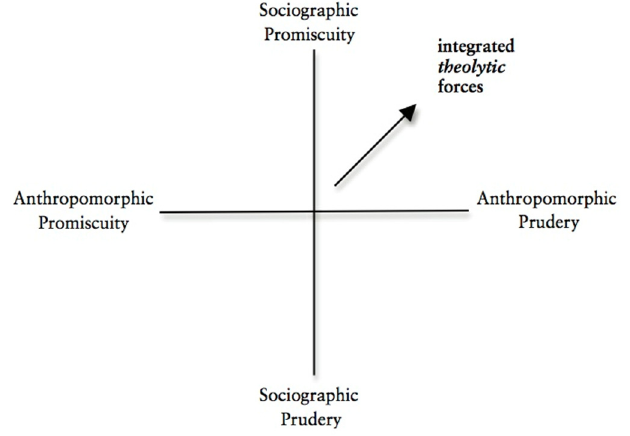
Figure 2. Theolytic